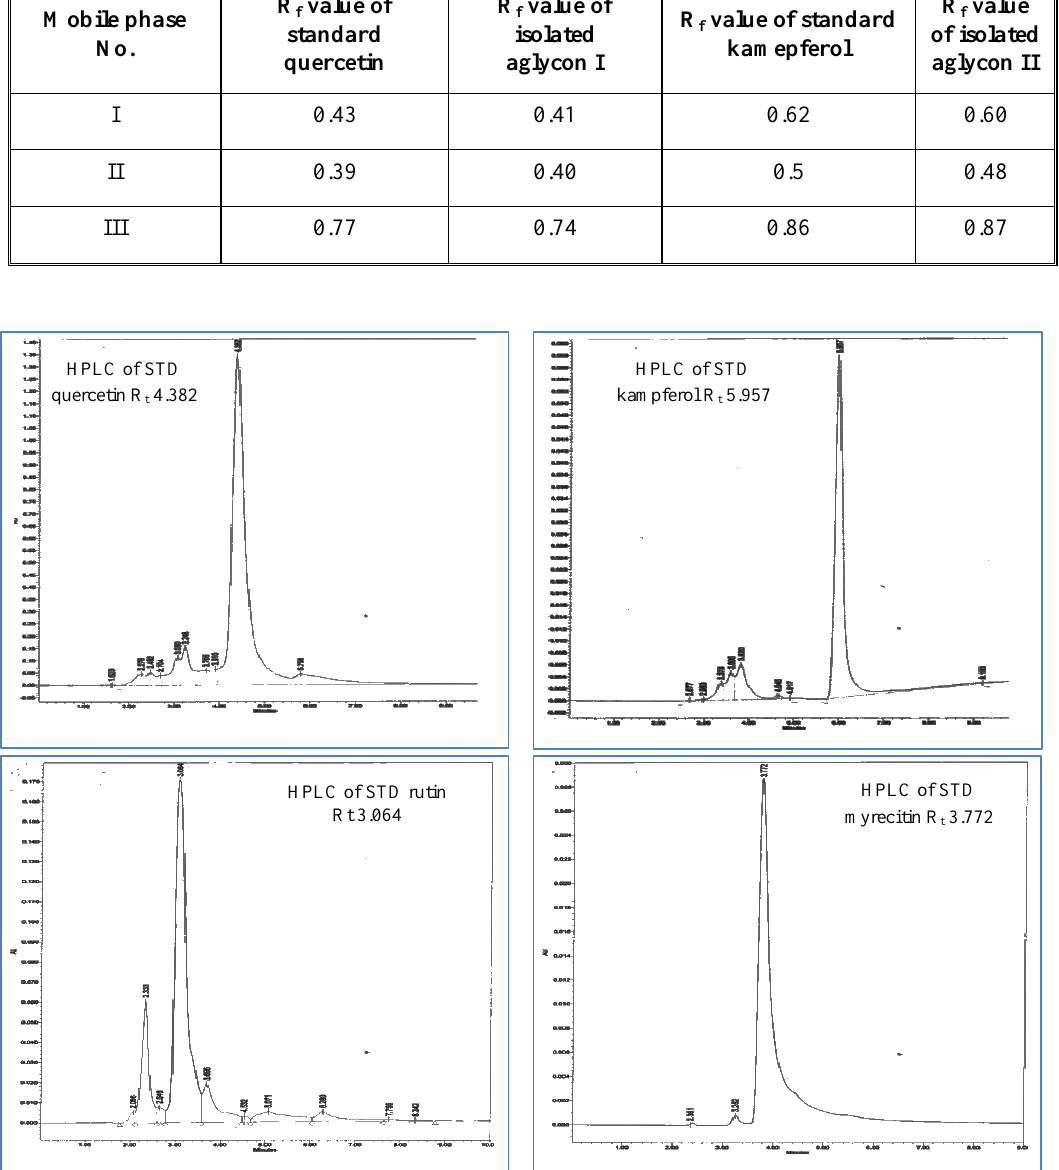
Table (I):- R values of standard quercetin and kaempferol compared with isolated aglycons I&II f in different mobile phases.